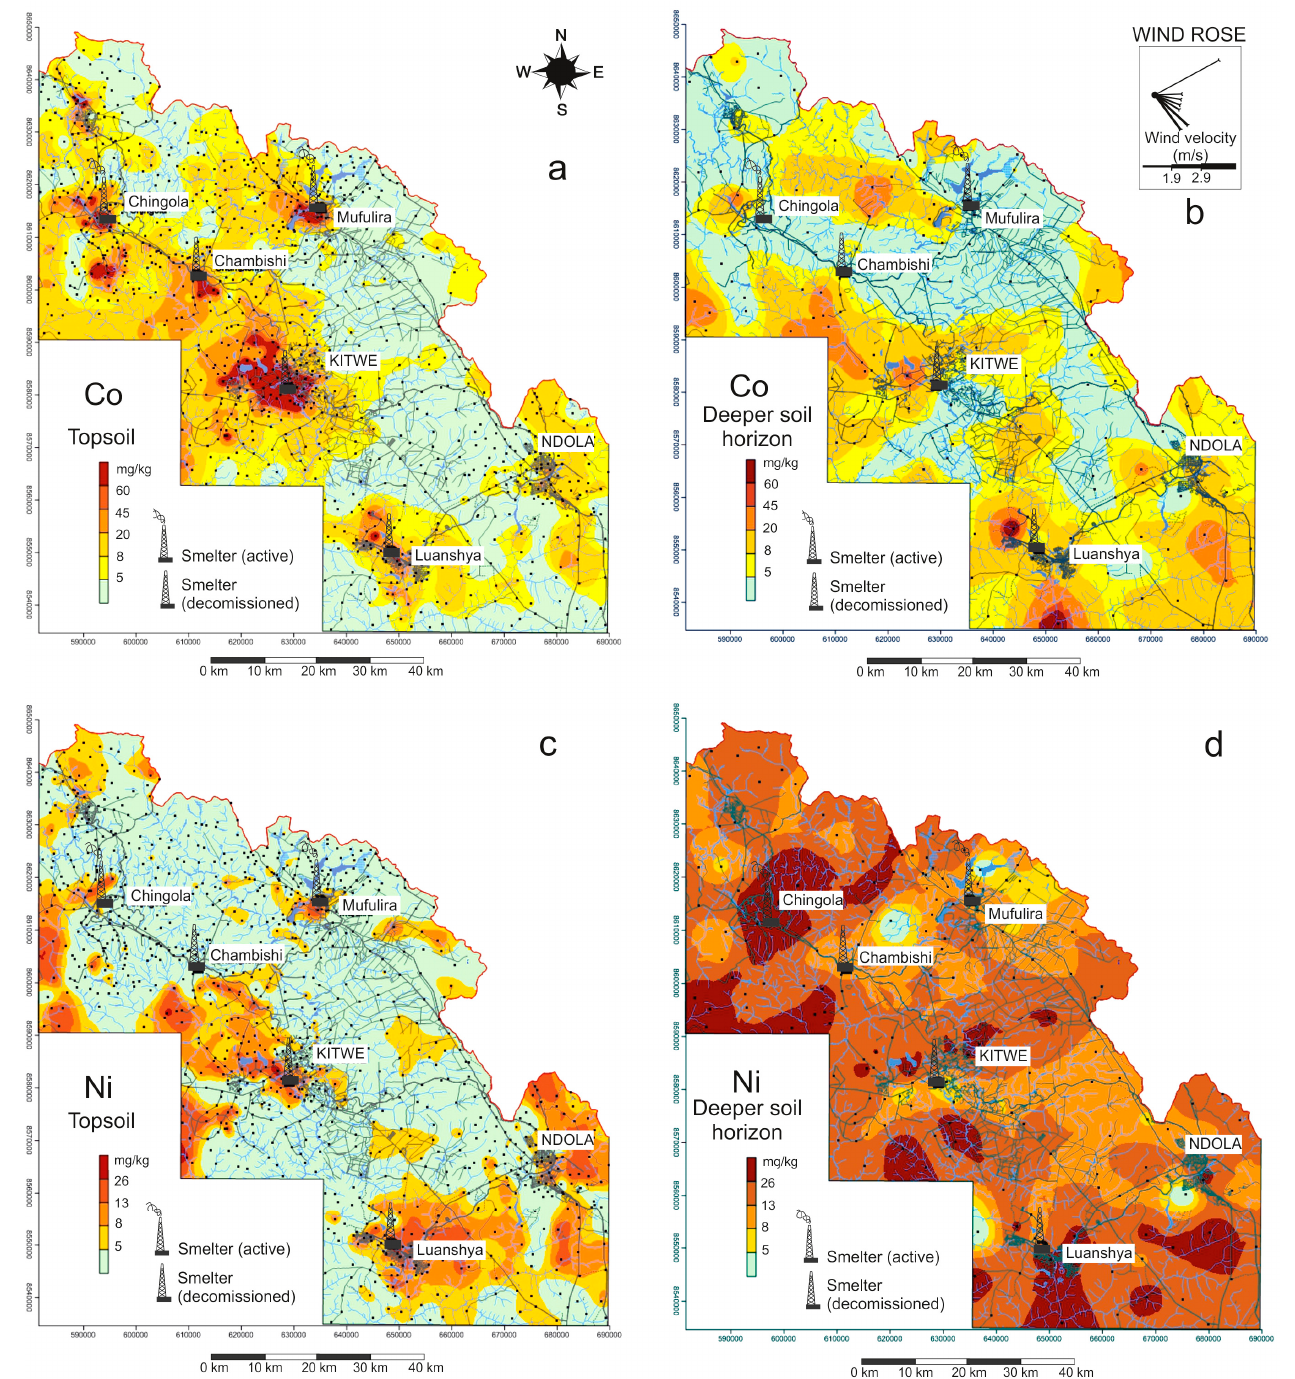
Figure 8. Contour maps of selected parameters on Zambian Copperbelt Mining districts. ( a ) Contour map of the Co concentrations in the topsoil, ( b ) contour map of the Co concentrations in the deeper soil horizon, ( c ) contour map of the Ni concentrations in the topsoil, ( d ) contour map of the Ni concentrations in the deeper soil horizon. Sampling points are shown as black dots. Modified after K ř íbek and Nyambe [74].